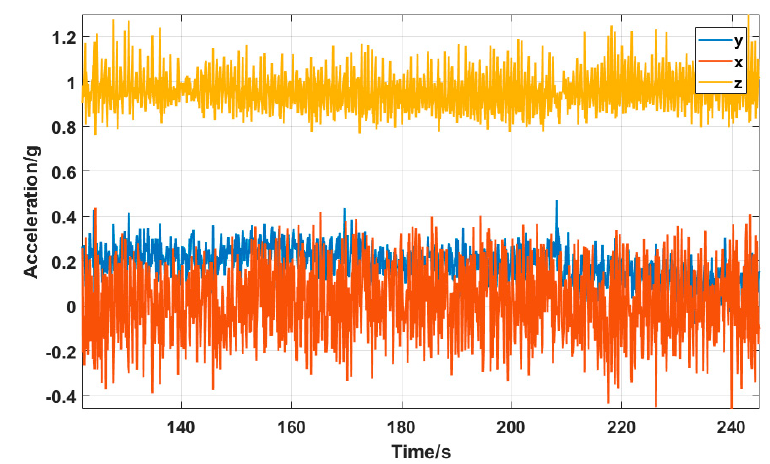
Figure 14. Triaxial acceleration data.